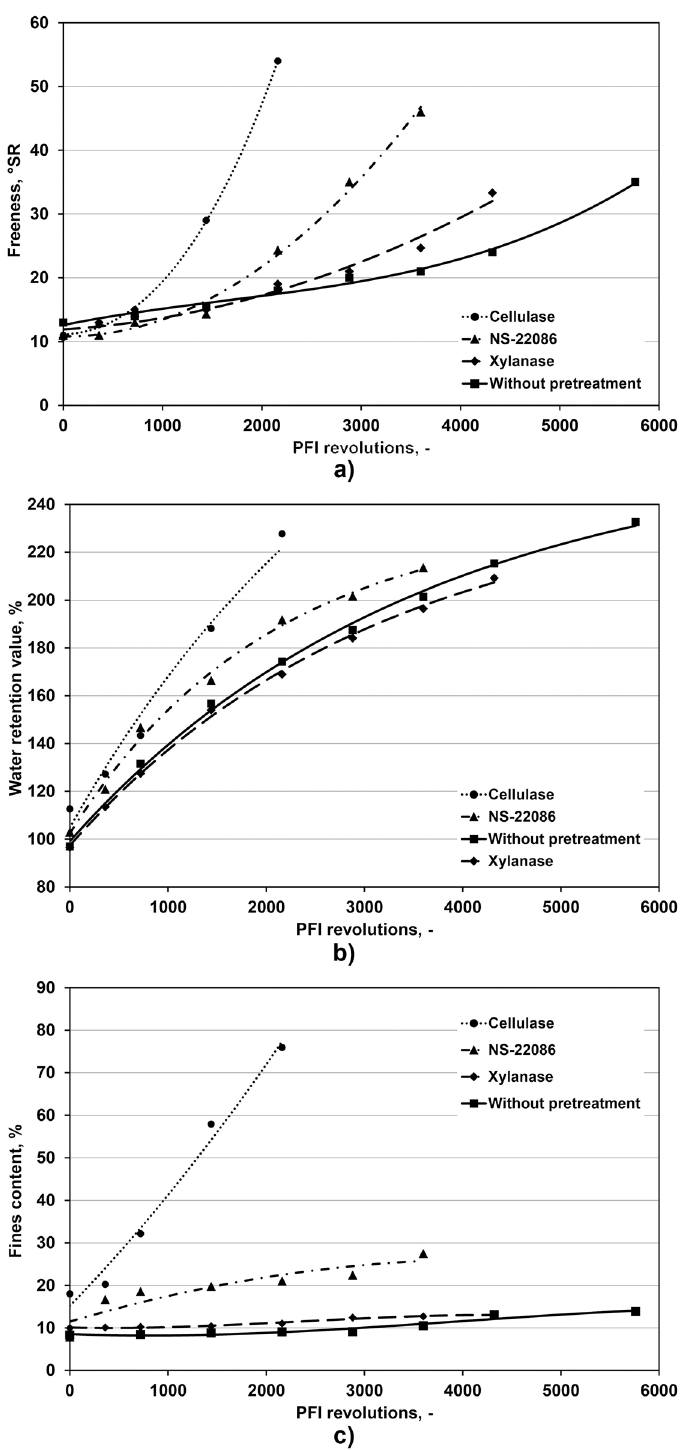
Fig 1. Effects of enzyme treatment and PFI revolutions number on pulp freeness (a), water retention value (b) and fines content (c).